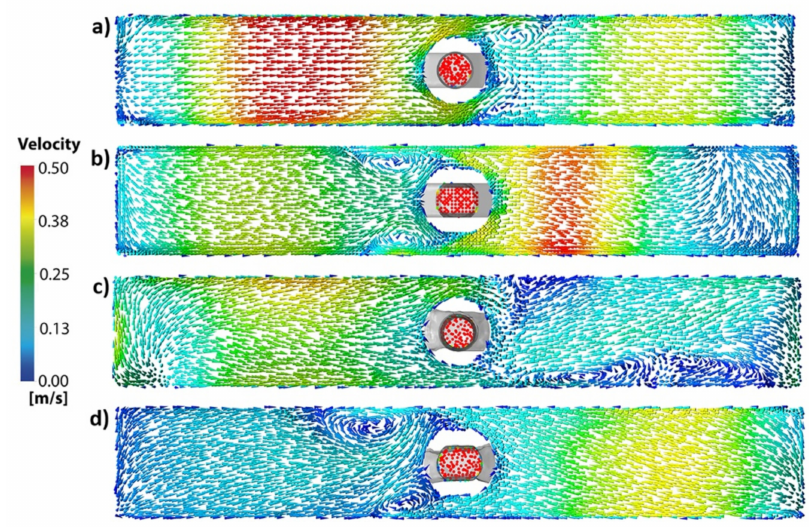
Figure 23. Velocity fields at the sub-surface (20 mm below the free surface). ( a ) Nozzle A without clogging. ( b ) Nozzle B without clogging. ( c ) Nozzle A with clogging. ( d ) Nozzle B with